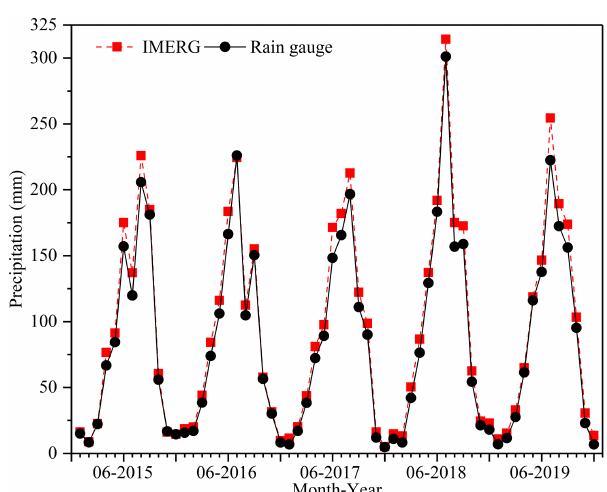
Figure 2. Average monthly precipitation of all rain gauges and that of IMERG at the corresponding grid cells from 2015–2019 over Sichuan